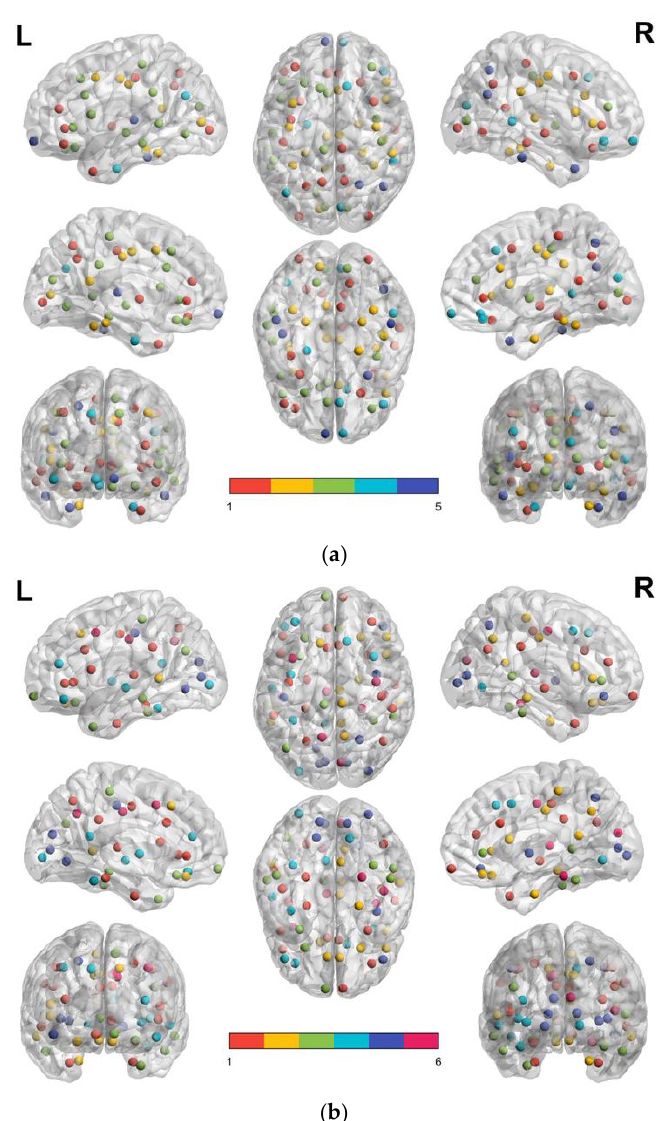
Figure 3. The node distribution of modules in the FD-based brain structural network for the control and MCI groups.( a ) The distribution of cerebral subregions in each modules of control participants group; ( b ) the distribution of cerebral subregions in each modules of brain structural network of patients with MCI. In each subfigure, red dots demonstrate the nodes of Module 1, yellow dots for Module 2, green dots for Module 3, turquoise dots for Module 4, and royal blue dots for module 5.